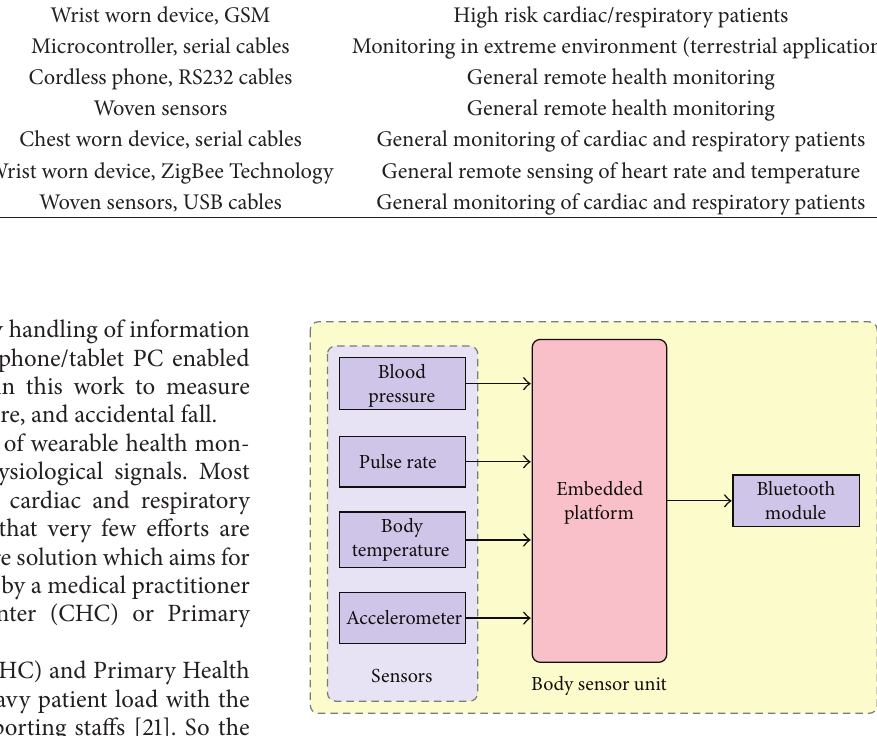
Figure 1: Block diagram of the developed body sensor